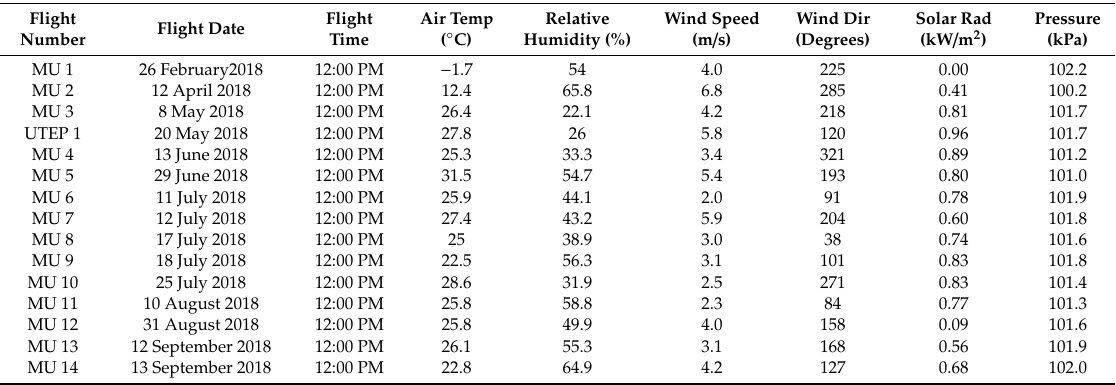
Table 2. Flight log and summary of meteorological variables recorded for Marquette and UTEP during fifteen noon flights.